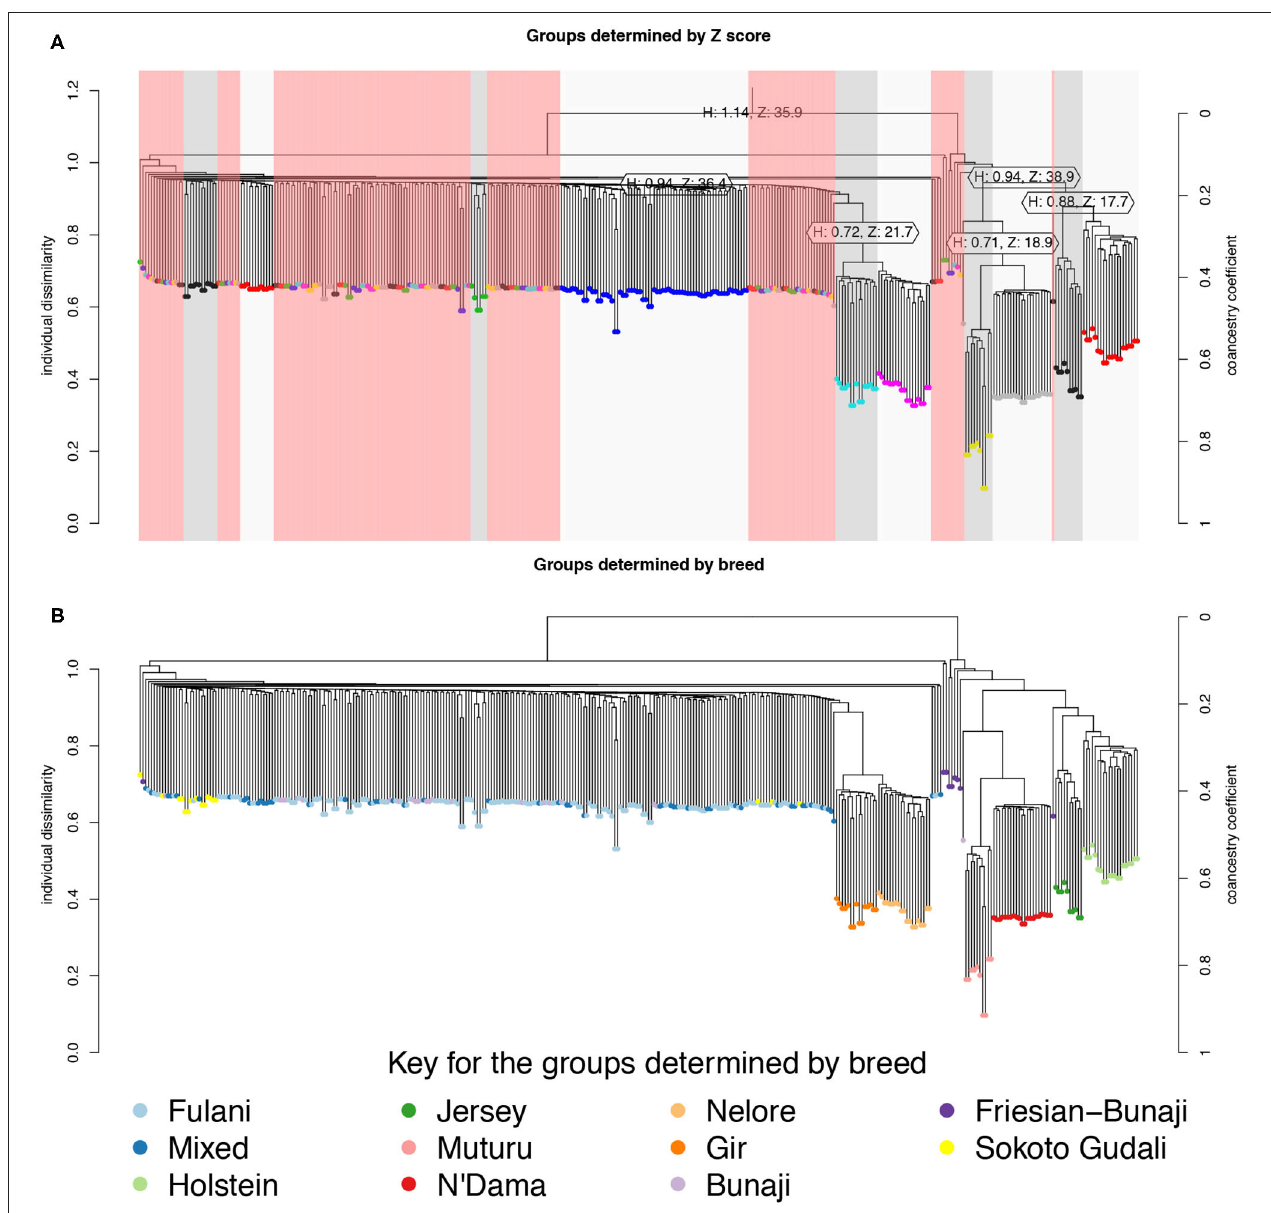
FIGURE 3 | Hierarchical clustering of the IBS matrix. (A) Shows the groups as determined by individual dissimilarity and z-score, the color of the nodes represent membership to each of the clusters using a z-threshold of 15. The gray and white highlighted areas symbolize the cluster groups, each labeled with their unique cluster name. The red highlighted areas represent the outliers, which are made up of clusters with < 5 individuals in them. (B) Shows the hierarchical relationship amongst individuals, the nodes are shaded according to the local abattoir employee’s definition of